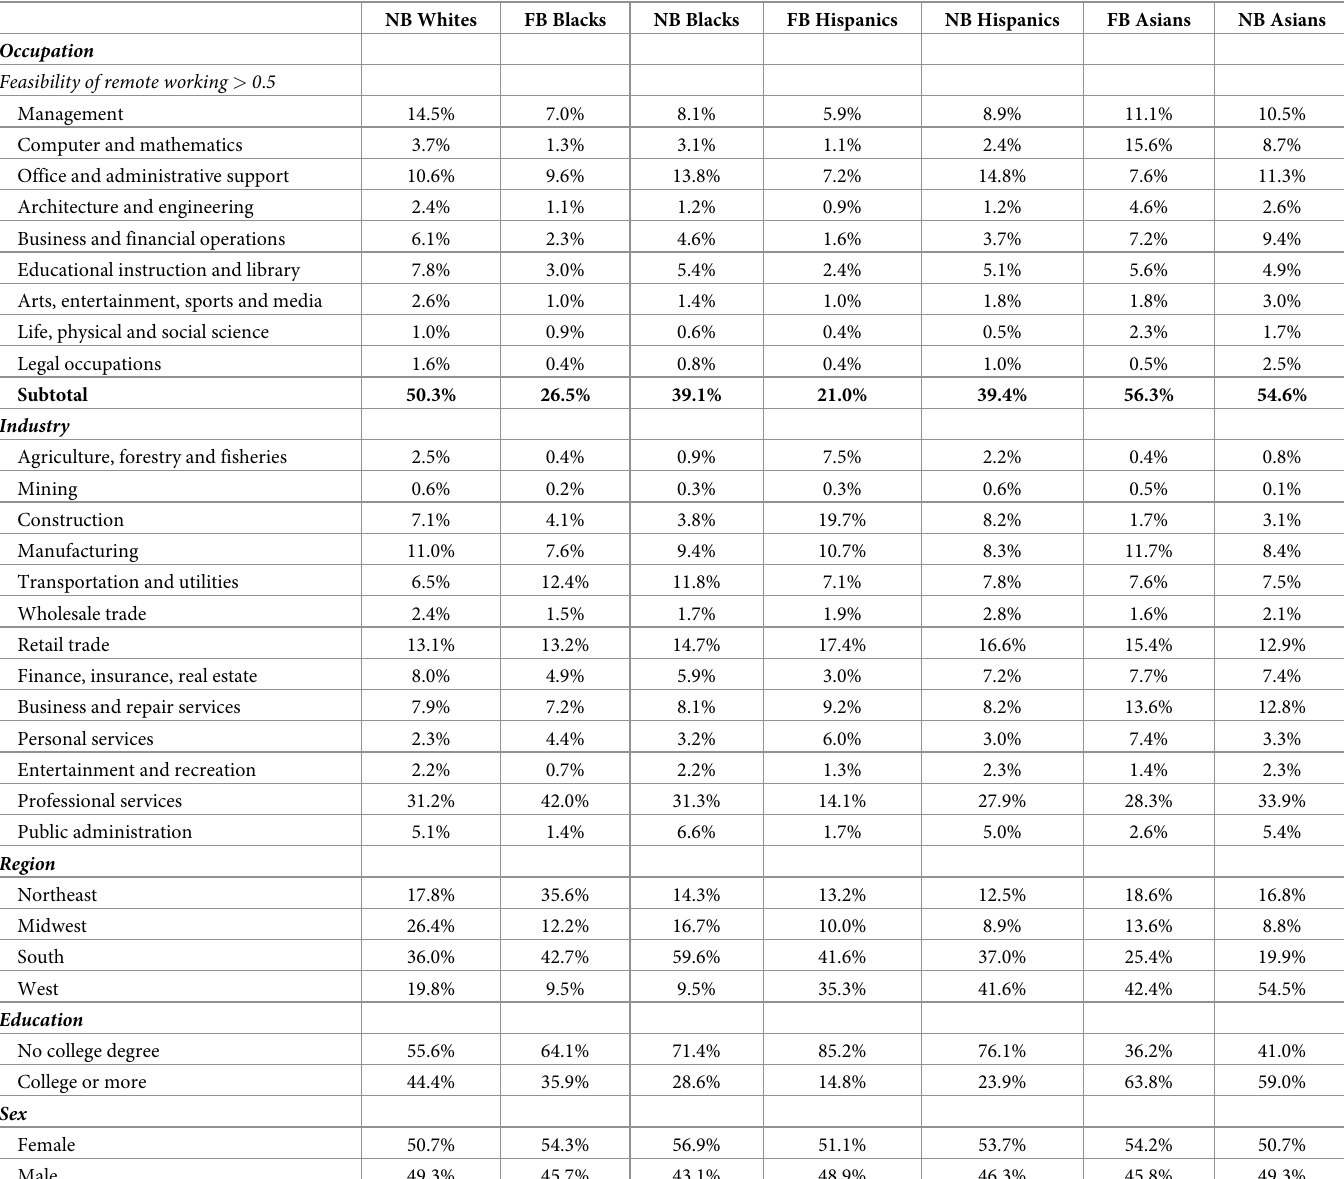
Table 1. Descriptive statistics of key variables by immigrant status and race/ethnicity among men aged 25–55 in the labor force (CPS 2019, wave